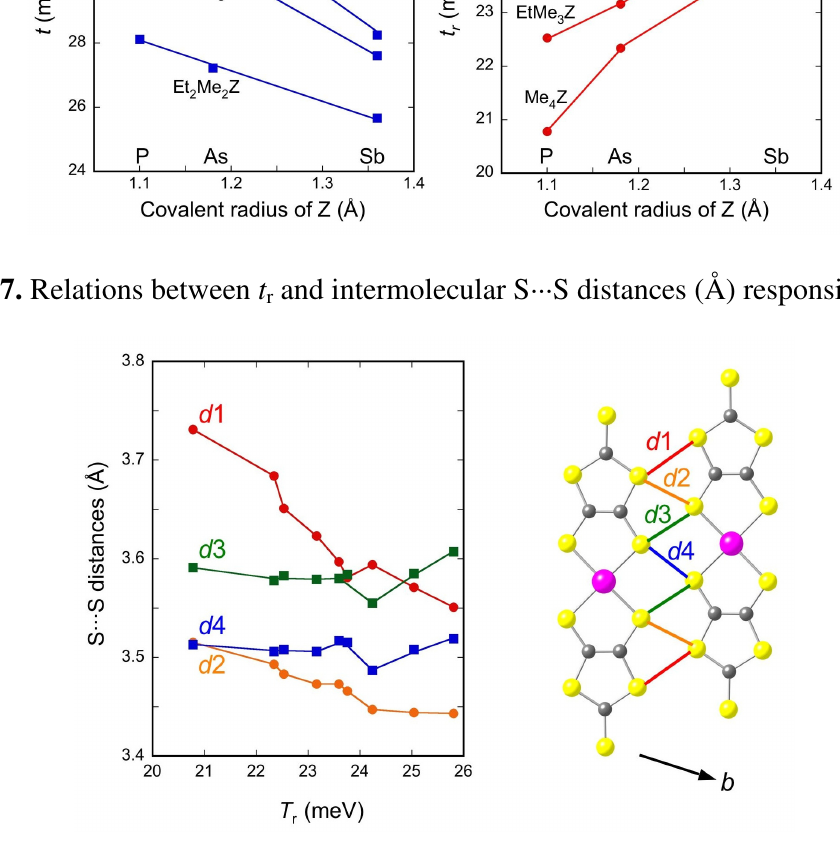
Figure 6. Intermolecular highest occupied molecular orbital (HOMO)-HOMO transfer integrals t and t (See Table 3) plotted as a function of the covalent radius of the central r ). atom Z ( R Z